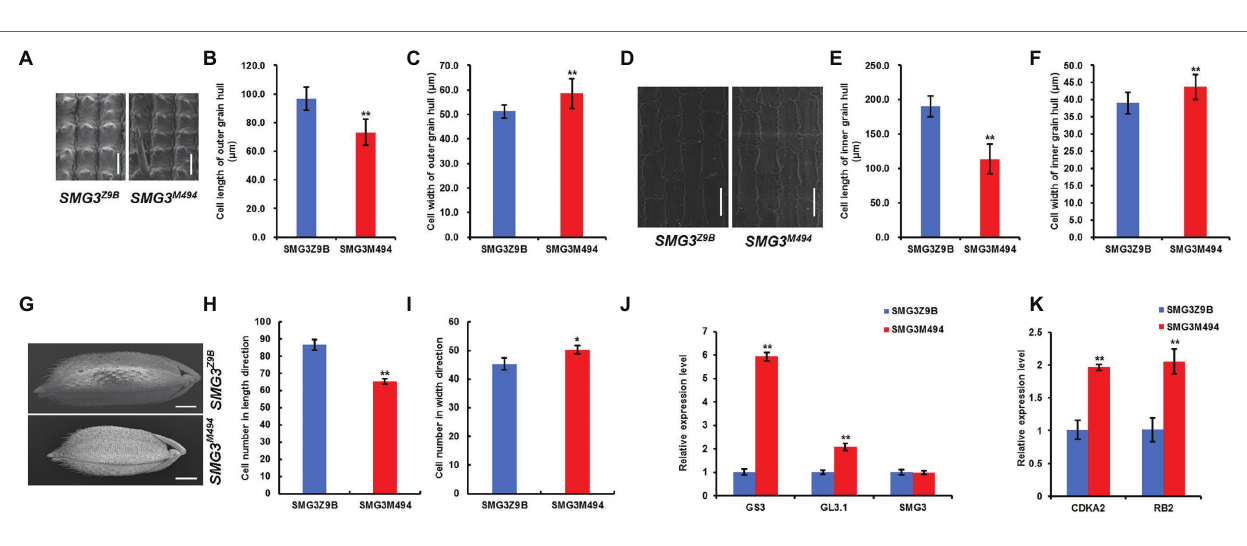
NIL- SMG3 Z9B , only the expression levels of GS3 and GL3.1 / qGL3 were significantly raised in the NIL- SMG3 M494 ( Figure 4J ), and the expression levels of GL7 / GW7 , GS2, and GS5 were similar between NIL- SMG3 M494 and NIL- SMG3 Z9B (data not shown). A similar difference was observed between Nipponbare and the SMG3 overexpression plants ( Supplementary Figure 4 ).